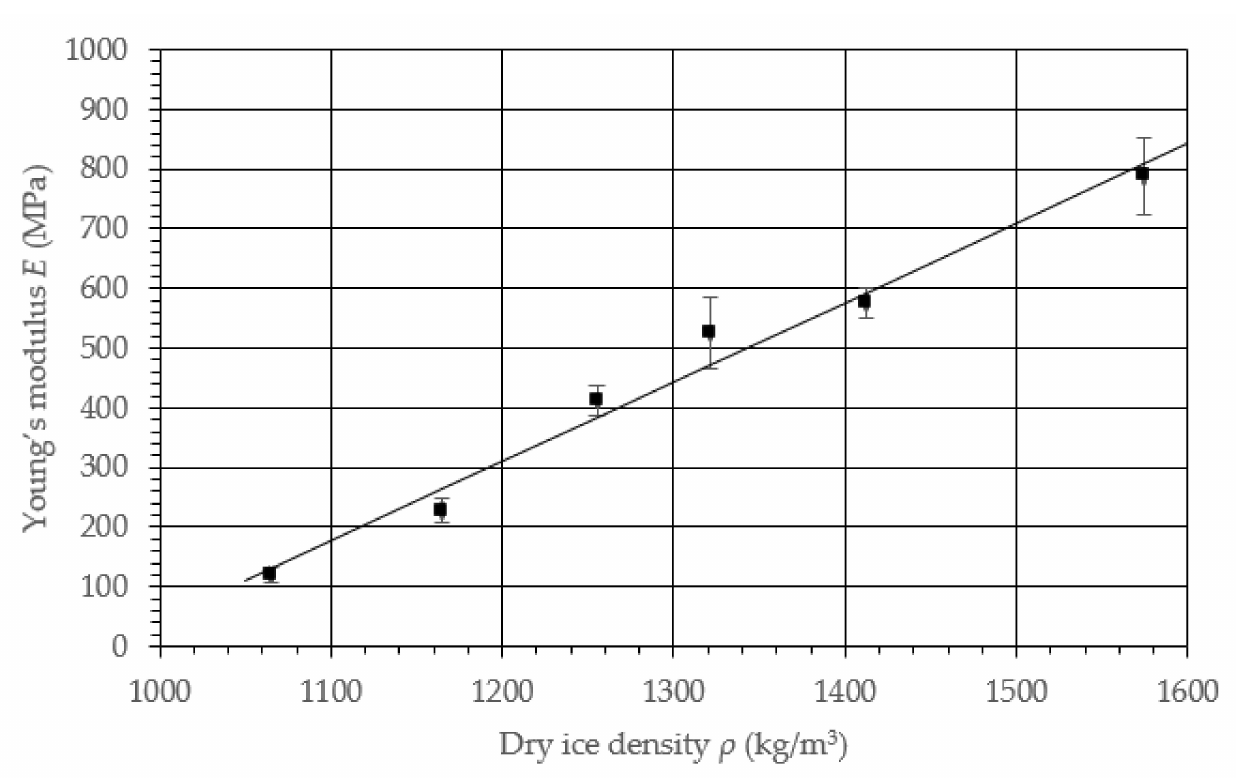
Figure 10. Characteristic curve for the Young’s modulus E value change as a function of the density ρ for dry